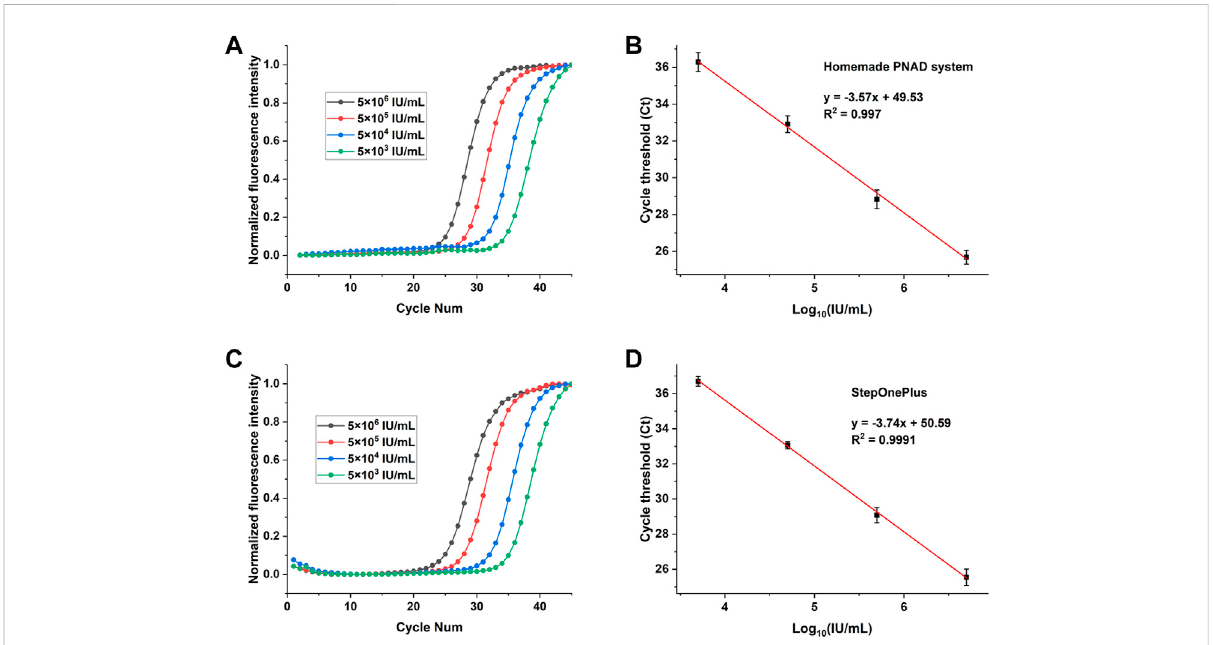
FIGURE 8 Real-time fl uorescence PCR curves (left) and their standard curves (right) for detection of HBV with concentrations ranging from 5 × 10 6 IU/ml to5×10 3 IU/ml. (A) and (B) :The real-time PCRcurves andstandardcurvesfor Ctvalues fromthehomemade PNADsystem. (C,D) :The fl uorescence curves and standard curves for Ct values from StepOnePlus system.